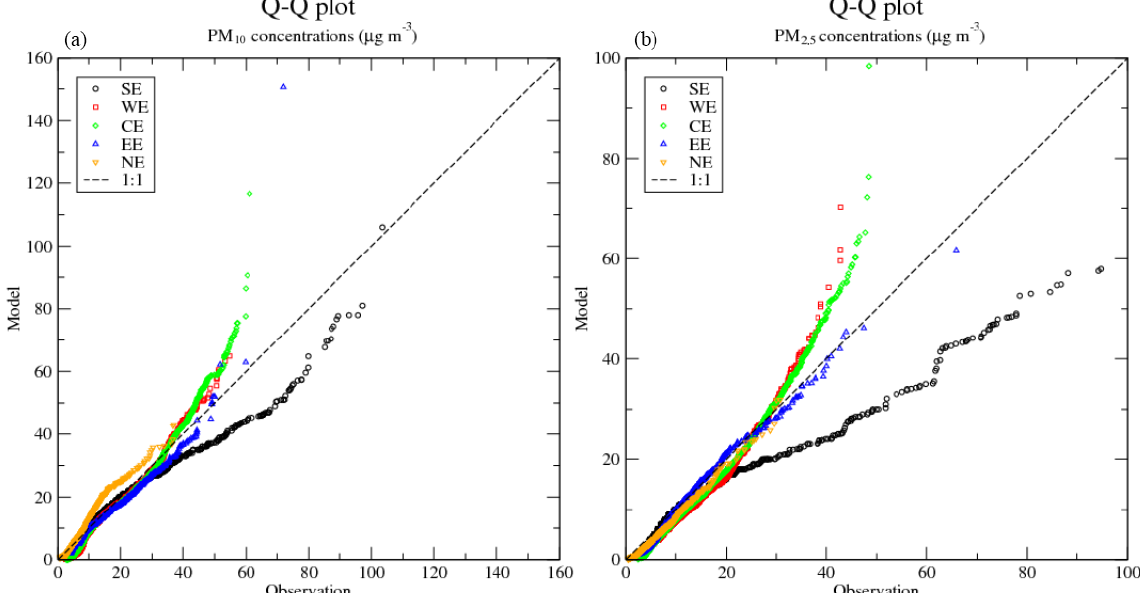
Figure 12. Q–Q plot of PM 10 (a) and of PM 2 . 5 (b) modeling results against measurements for the several regions. SE: southern Europe. WE: western Europe. CE: central Europe. EE: eastern Europe. NE: northern Europe.